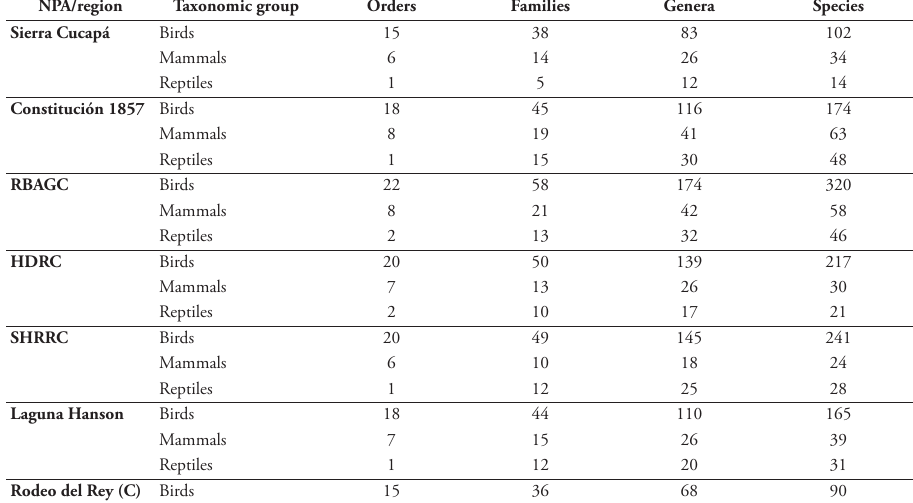
Table 2. Number of orders, families, genera, and species of birds, mammals and reptiles recorded in Sierra Cucapá and six NPAs of northern Baja California: Parque Nacional Constitución de 1857, Reserva de la Biosfera del Alto Golfo de California (RBAGC), Humedales Remanentes del Río Colo- rado (HDRC), Sistema de Humedales Remanentes del Río Colorado (SHRRC), Laguna Hanson, Ro- deo del Rey